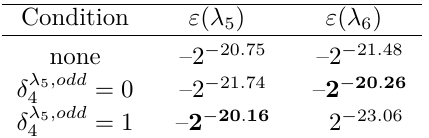
Table 13: The Bias of λ 5 and λ 6 Conditioned on δ λ 5 ,odd